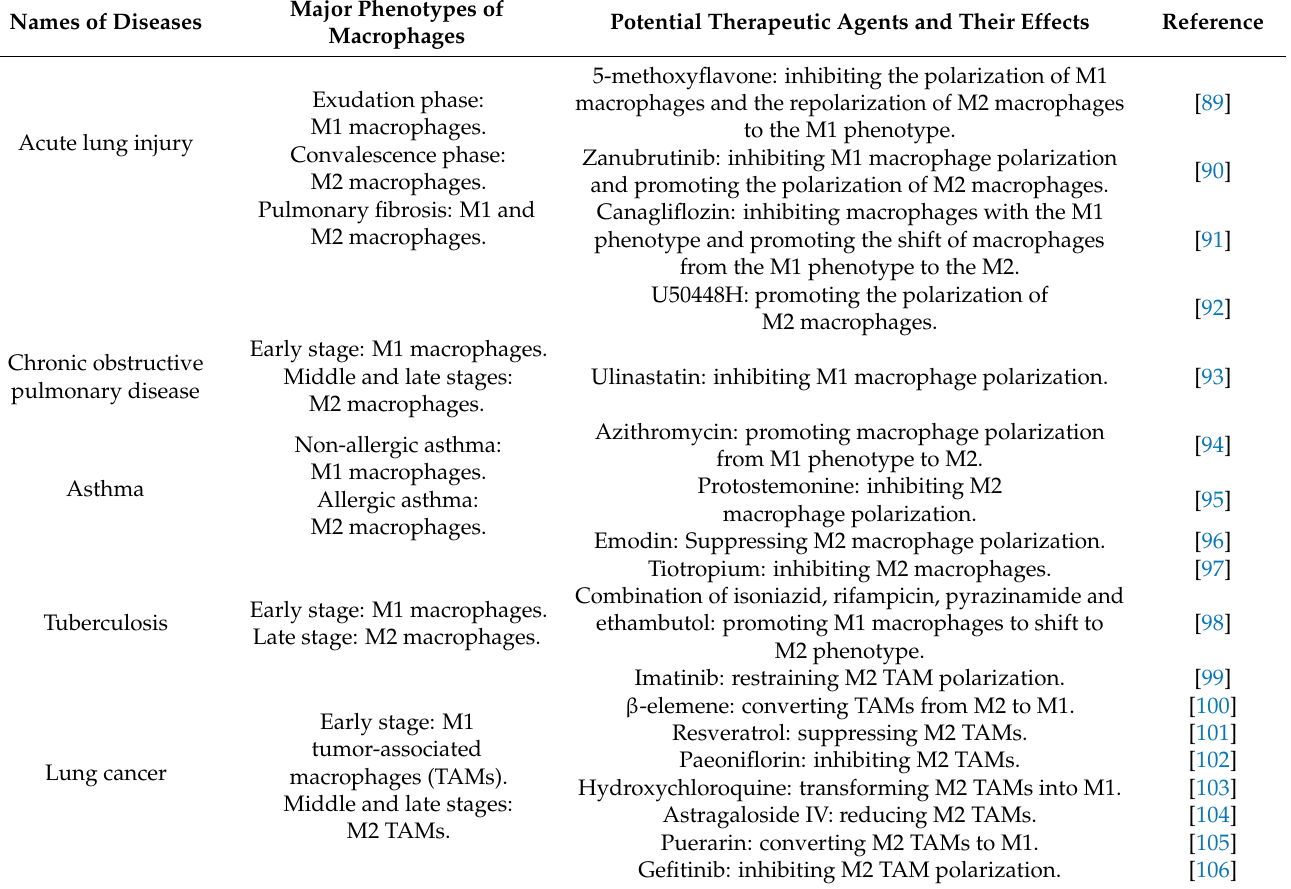
Table 1. Major phenotypes of macrophages in lung diseases and potential therapeutic